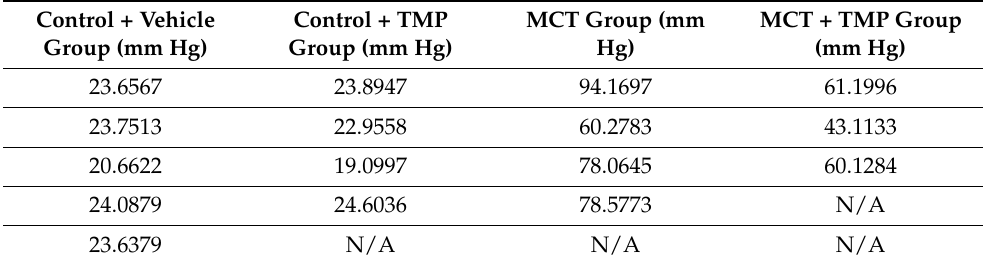
Table 4. In vivo right ventricle pressure hemodynamic measurements from microsprayer (liquid aerosol) study.